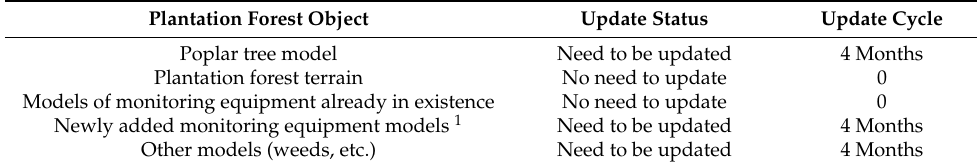
Table 1. Renewal of virtual poplar plantation forest objects.